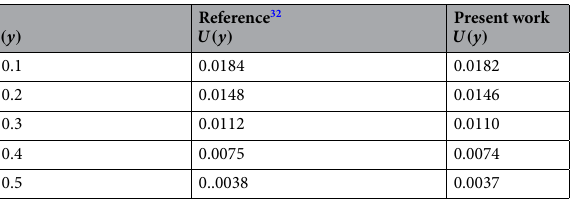
Table 1. Shows numerical computations comparing Reference 32 work to the present work for velocity profiles with varying value of y . γ = 0.1, (cid:31) = 0.1 Da = 100000, Br = 0.1 Ha = 0.